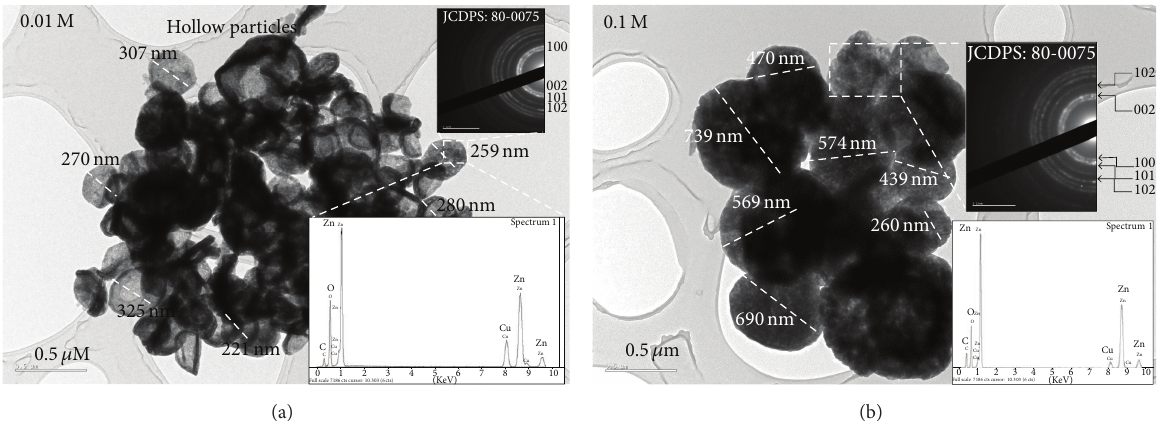
Figure 5: TEM and HRTEM micrographs of ZnO nanoparticles synthesized at various precursor concentrations. (a) 0.01M showing hollow and quasi-spherical particles and (b) 0.1M showing dense, quasispherical, and bigger particles.